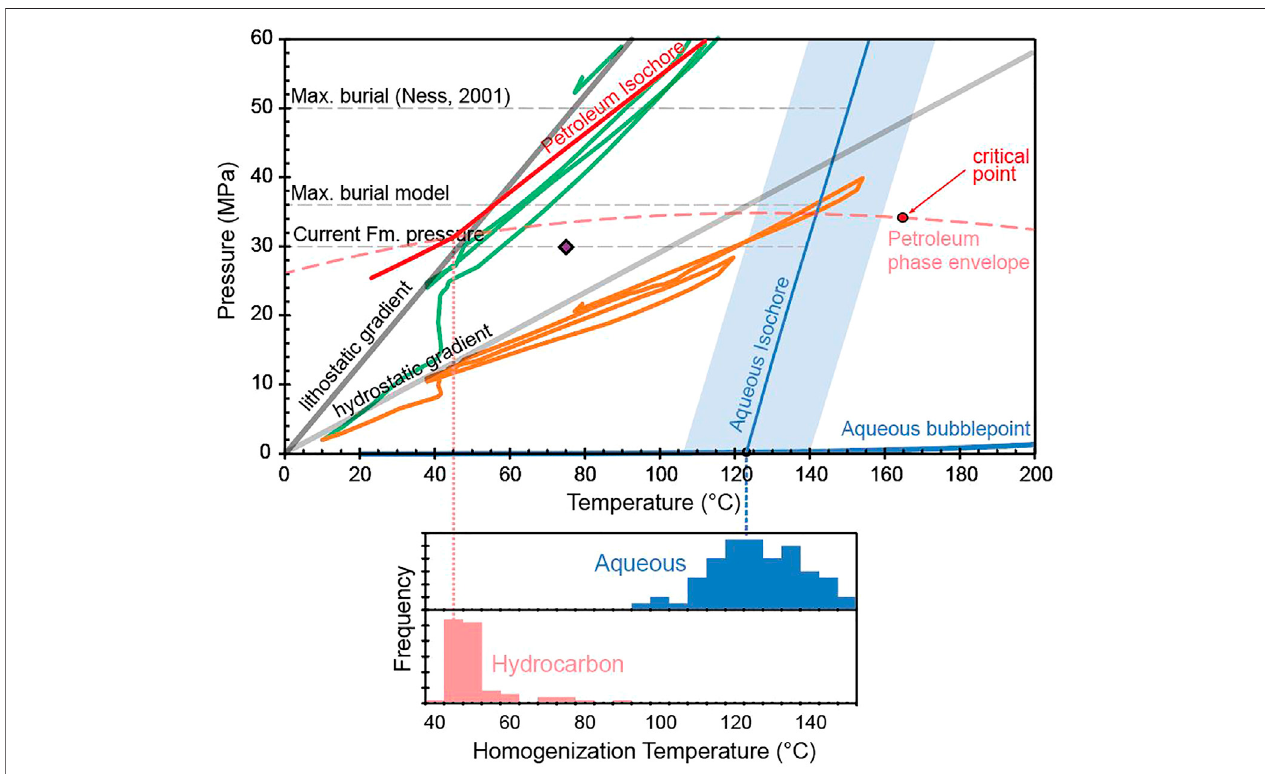
FIGURE12| Pressure-temperaturemodelingforpetroleum fl uidinclusionsshownalongsideaqueousisochore.Notethataqueousandhydrocarboninclusionsare not coeval. Phase envelope calculated using PVTsim (Calsep Co.) from locally derived recombined hydrocarbon fl uid composition (red dashed line). Current formation pressure shown as purple diamond. Petroleum inclusion isochores (red solid line) calculated using an average homogenization temperature of 45 ° C and petroleum fl uid compositions from recombined Montney fl uids.